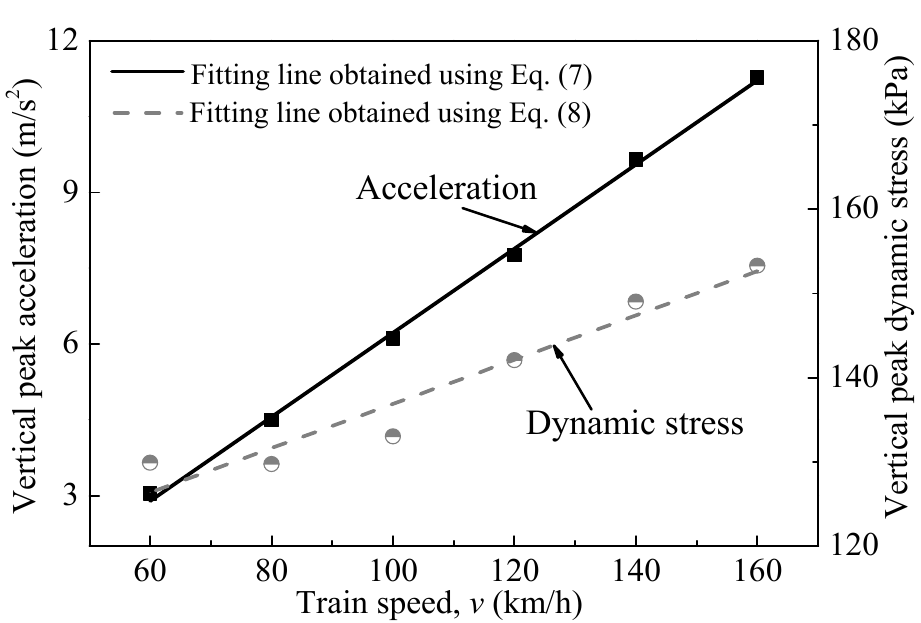
Figure 9. Variation of vertical peak acceleration and dynamic stress at the center of the top layer surface with the train speed.